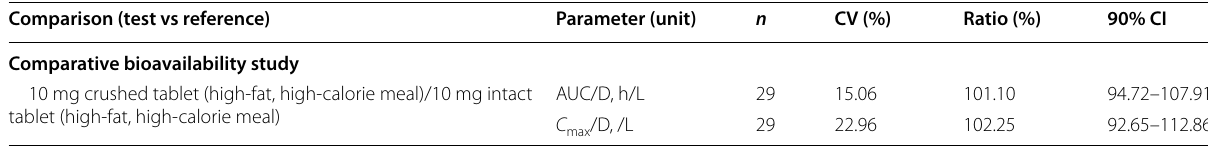
Geometric CV indicating intra-individual variability AUC/D Dose-normalized area under the curve, CI Confidence interval, C max Maximum plasma concentration, C max /D Dose-normalized maximum plasma concentration, CV Coefficient of variation, LS Least squares, PK Pharmacokinetic Ratio: LS means for the respective treatment ratio calculated by ANOVA